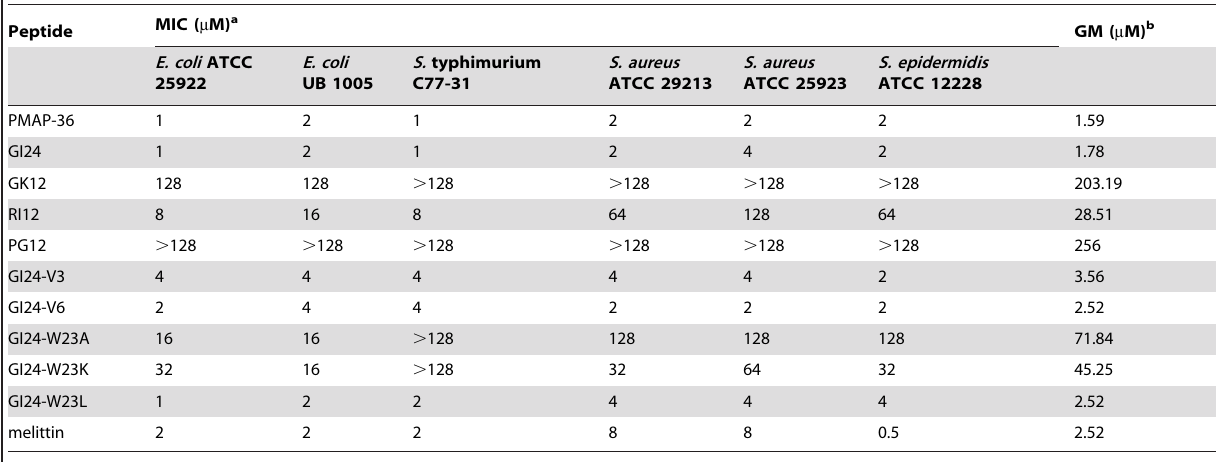
Table 2. Antimicrobial activity of the peptides.